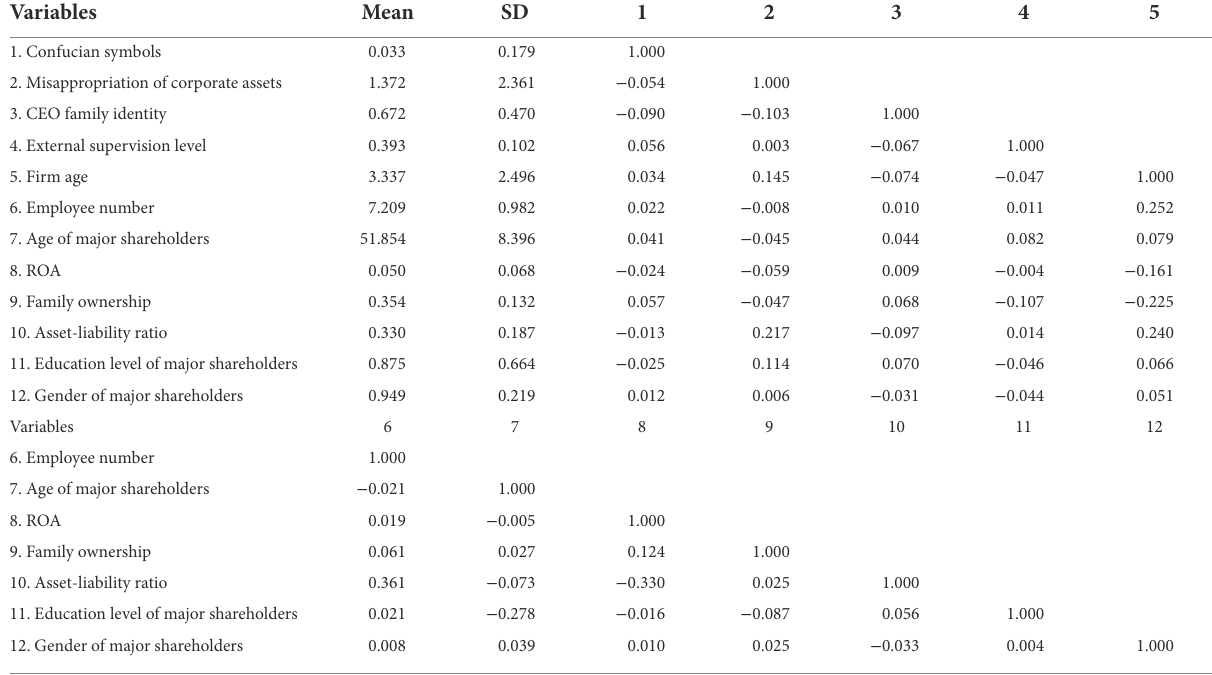
TABLE 1 Descriptive statistics and